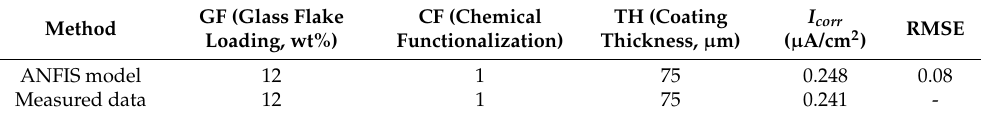
Table 5. Model validation